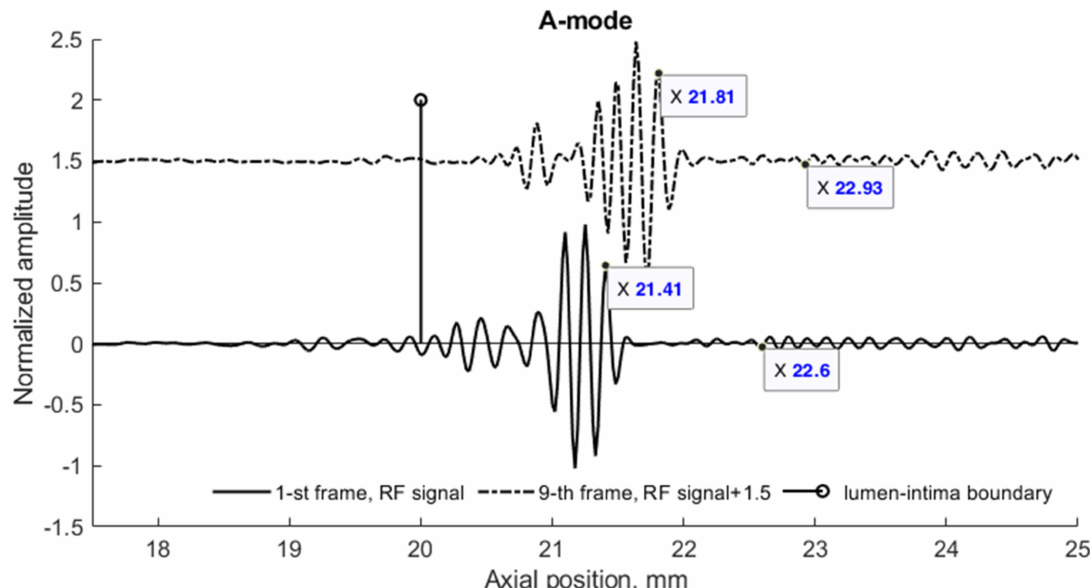
Figure 9. RF signals simulated by the 3D model of the pulsating artery at M-mode instances t 1 and t 2 . Distal wall and surrounding tissues scattered RF signals (the artery center at 17.5 mm) depicting the radial wall displacement and its decrease in surrounding tissues. A 23 years old male, motion amplitude was normalized to 1